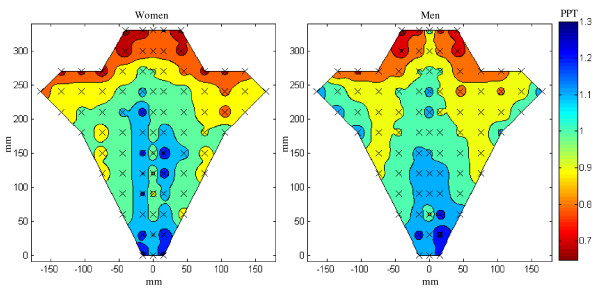
Normalized pressure pain threshold maps of the neck-shoulder region for women (N = 11) and men (N = 11). Note the symmetry along the spine and that the most sensitive part of the muscles is the upper region of the trapezius in both genders.